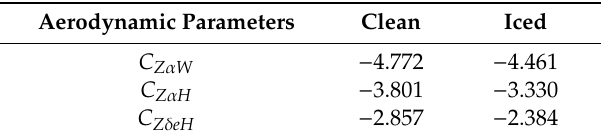
Table 9. Aerodynamic derivatives of the wings and horizontal tail.